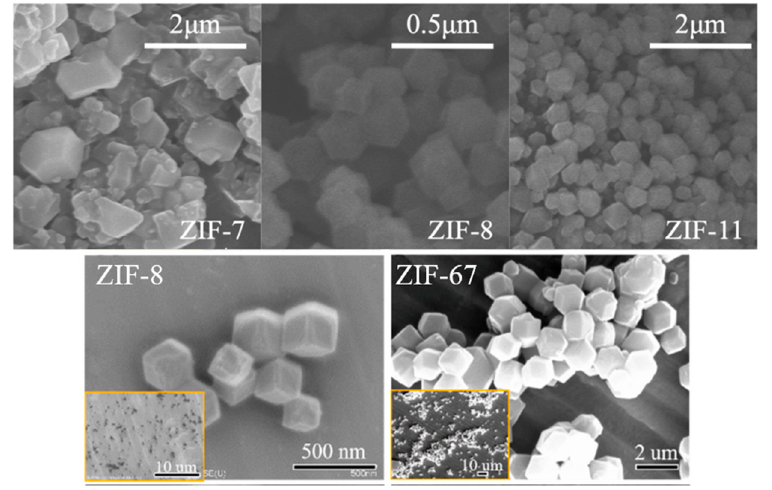
Figure 3. SEM images of ZIF-7, ZIF-8, and ZIF-11 ( above ) and ZIF-8 and ZIF-67 ( below ). Reprinted with permission from Ref. [26]. Copyright 2021 Elsevier and Ref. [34].